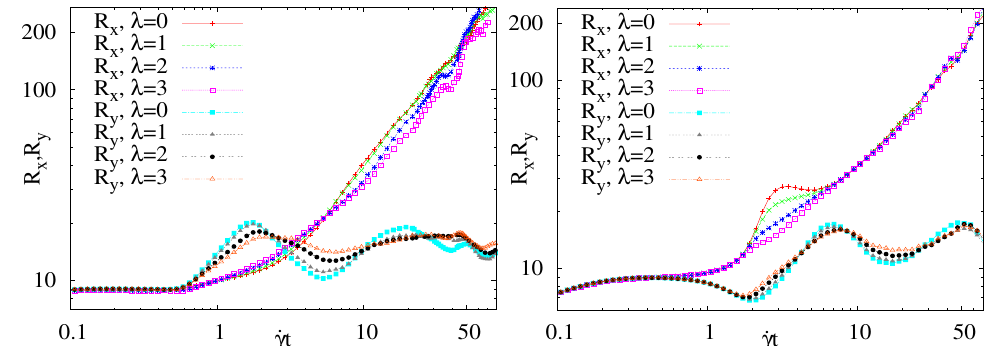
Figure 6. Average measures of domains along the flow ( R x ) and the shear ( R y ) directions as functions of time at weak ( left panel) and strong ( right panel) shear for different values of λ .